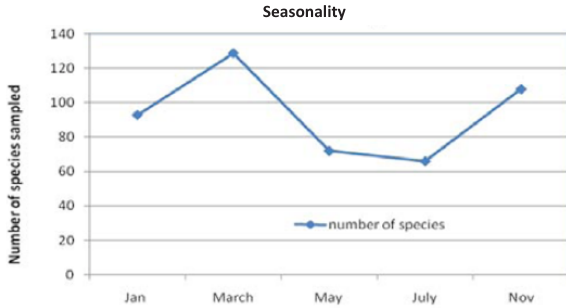
IndiaFigure 4. Seasonal variation in number of butterfly species (pooled) in subtropical lowland forests of Bhutan (January 2009–March 2010) (Singh